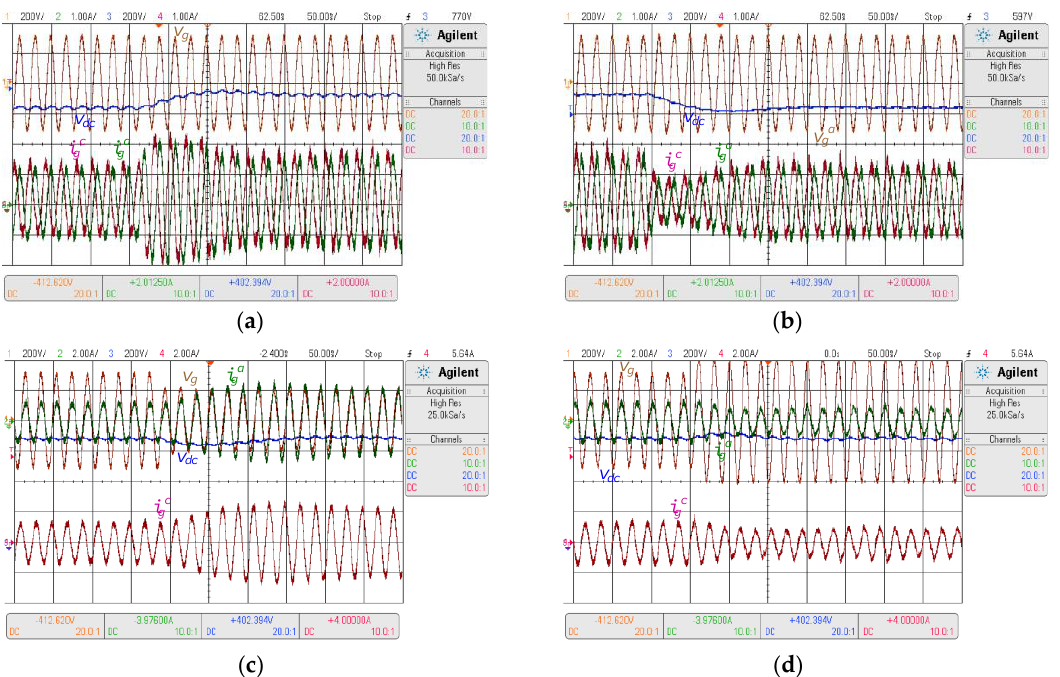
Figure 12. Experimental results with f s = 1.2 kHz ( a ) v dc step-up system response, ( b ) v dc step-down system response, ( c ) 30% sag system response, ( d ) 30% swell system response.